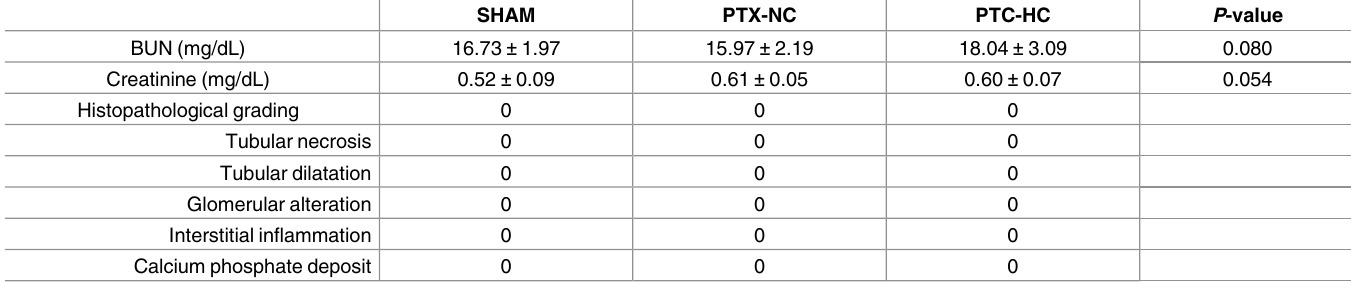
Table 3. Serum levels of blood urea nitrogen/ creatinine and histopathological grading of kidney at postoperative 8 weeks. Data are expressed as the means ± standard deviation.Histopathological gradingis marked as 0 = normal histology, 1 = < 25%, 2 = > 25%, but < 50%, 3 = > 50%, but < 75%, 4 = > 75%. Abbreviations: BUN, Blood urea nitrogen.